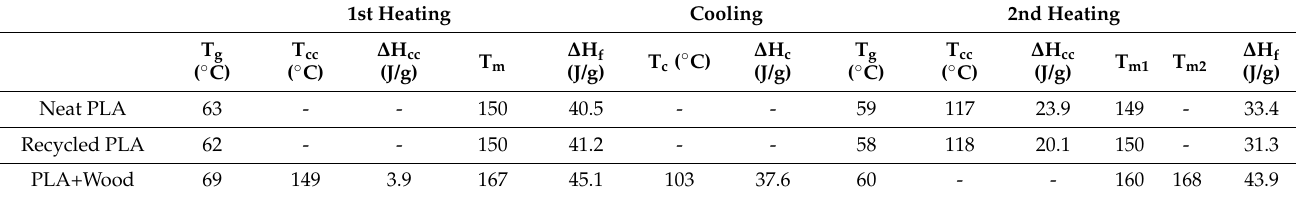
Table 2. DSC data for dried filaments during the first and second heating (glass transition, T g ), cold crystallization (T cc ) and melting (T m ) temperatures and corresponding enthalpies ( ∆ H cc , ∆ Hf), and cooling (crystallization temperature, T c ) and relative enthalpy ( ∆ H cc ).